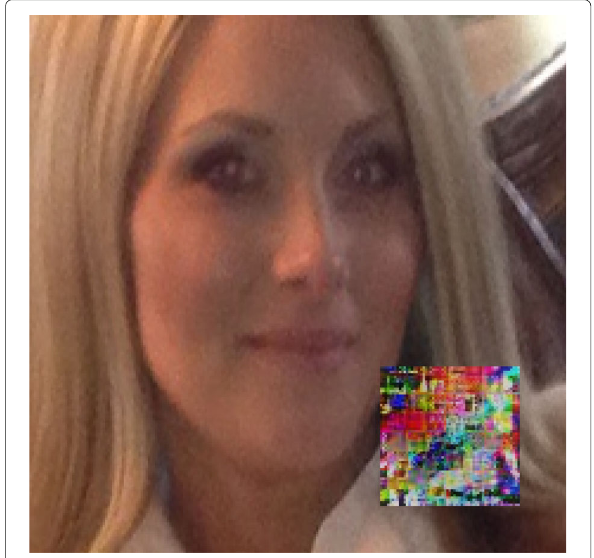
Fig. 10 Example of trojaned image for the age recognition